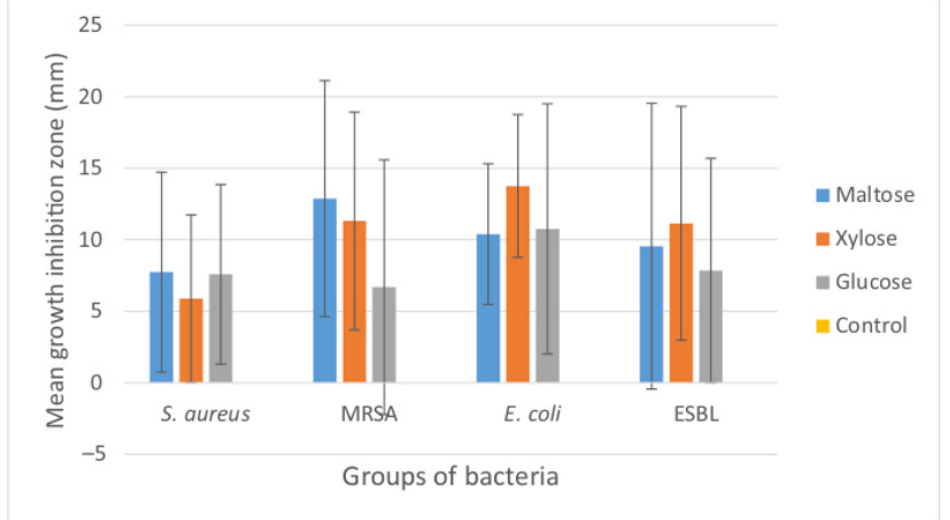
Figure 8. Mean growth inhibition zones (mm) caused by the three types of AgNP-containing foils produced using different reducing agents (maltose, xylose and glucose). The results are means of three replicates for the examined bacterial isolates ( n = 79) of S. aureus ( n = 45), MRSA ( n = 6), E. coli ( n = 17) and ESBL ( n = 11). Bars represent standard deviation. Control foils (sole alginate) caused no growth inhibition.